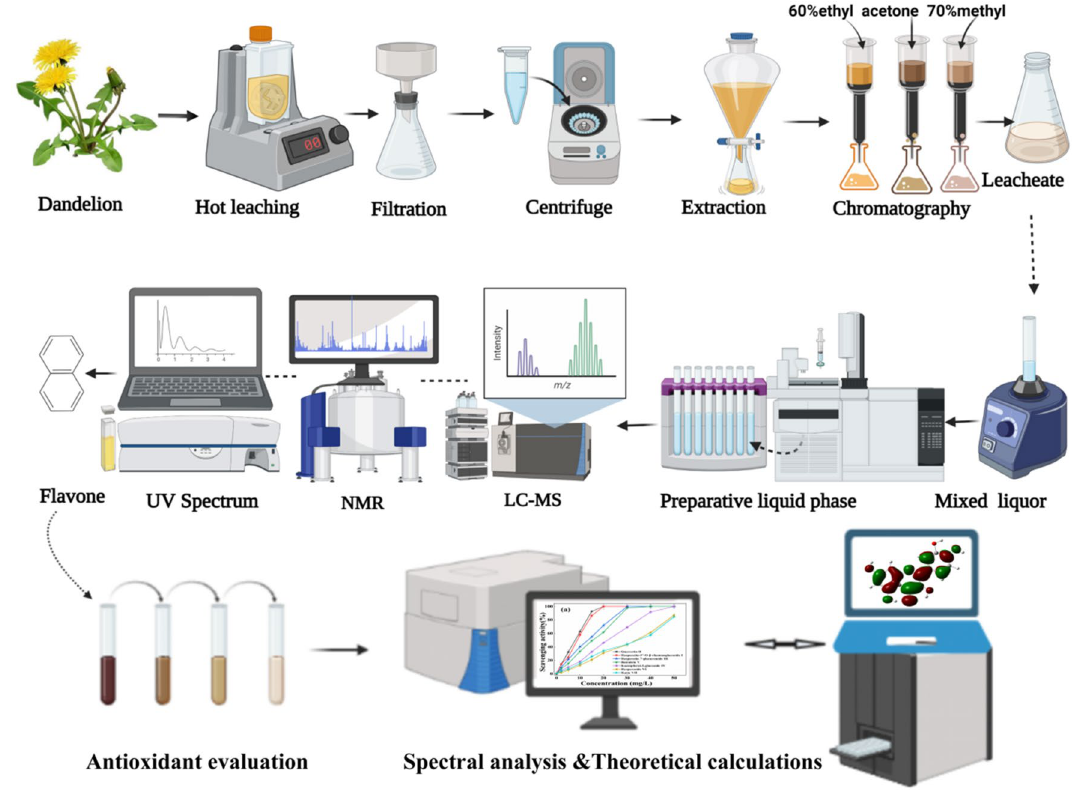
Figure 2. Schematic diagram demonstrating our research on extraction, purification, structural identification and antioxidant evaluation of the flavonoid compounds from Taraxacum mongolicum Hand.-Mazz